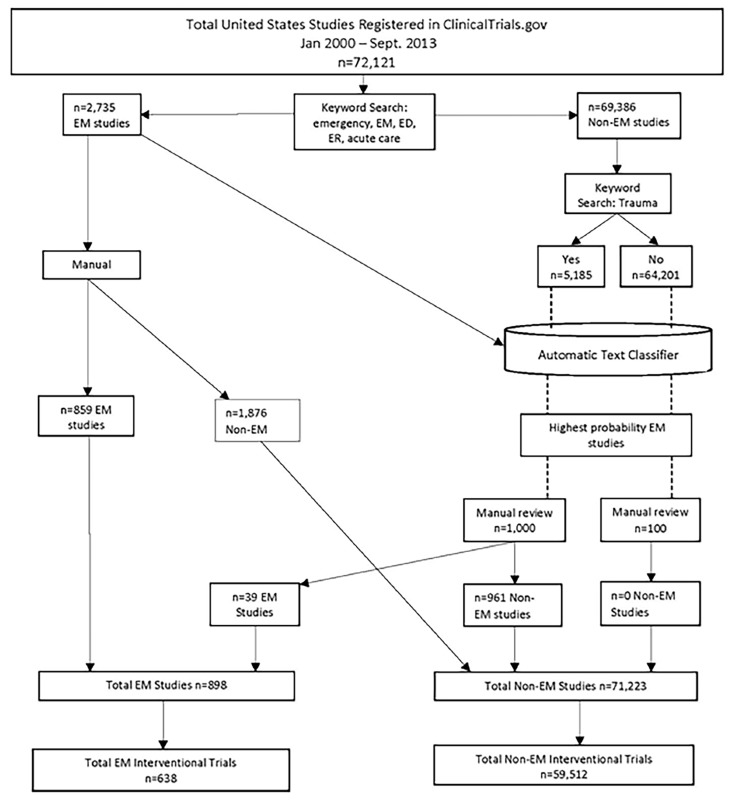
Emergency medicine (EM) and non-EM clinical trials inclusion flow chart.ED, emergency department; ER, emergency room.